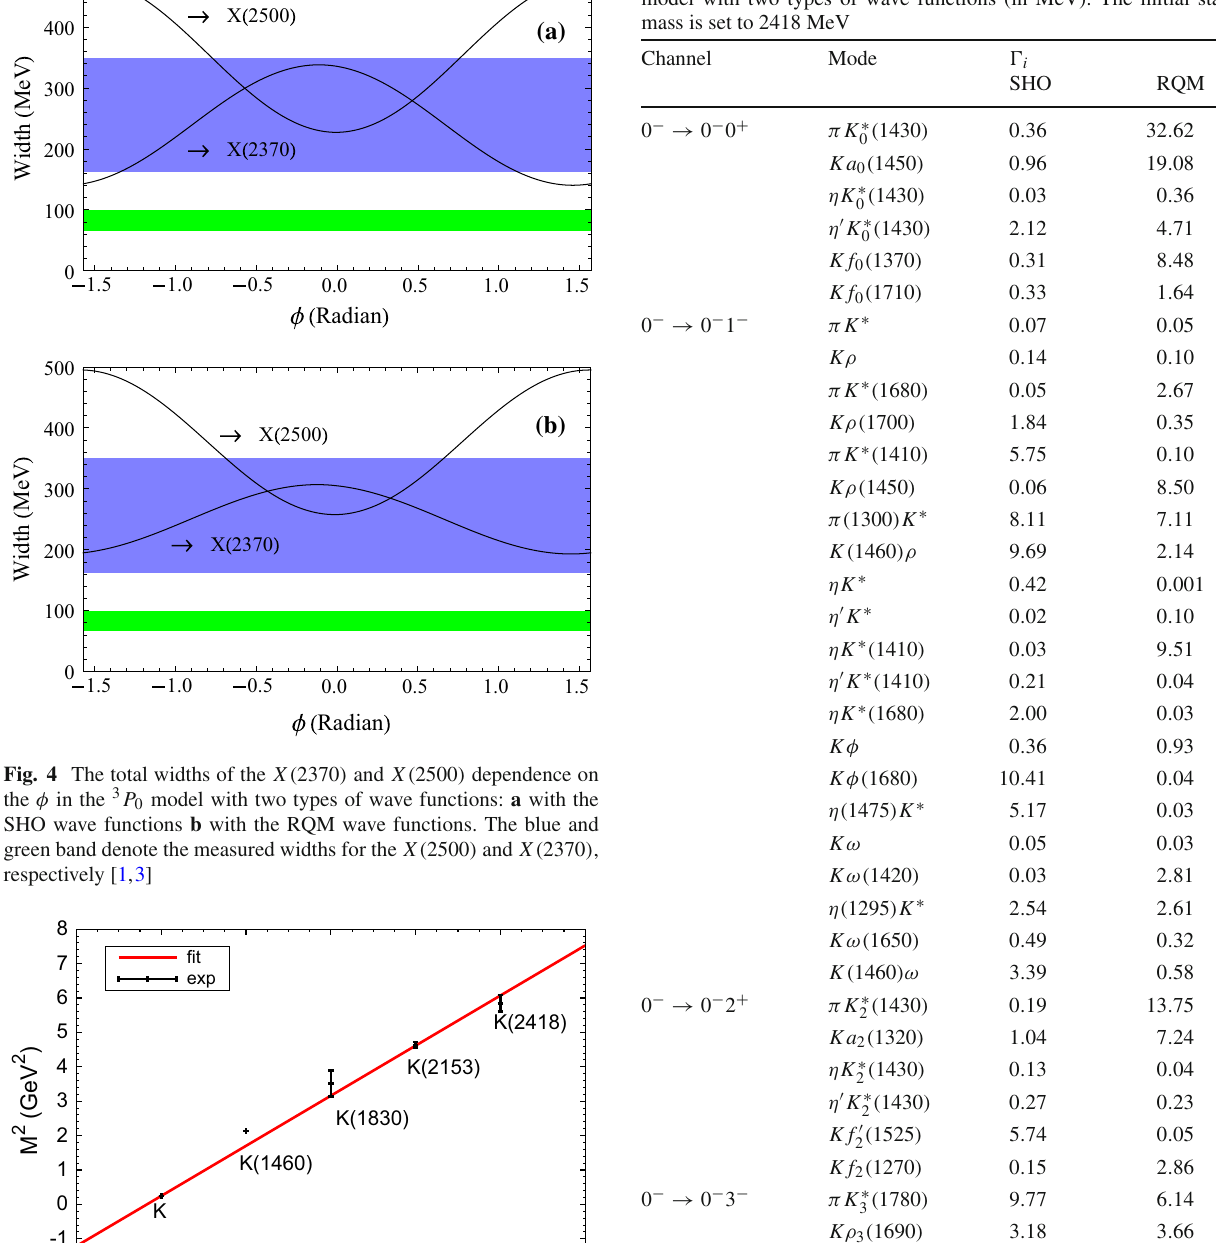
+ ( n − 1 )μ 2 . M 2 = 0 . 24669 ± 0 0